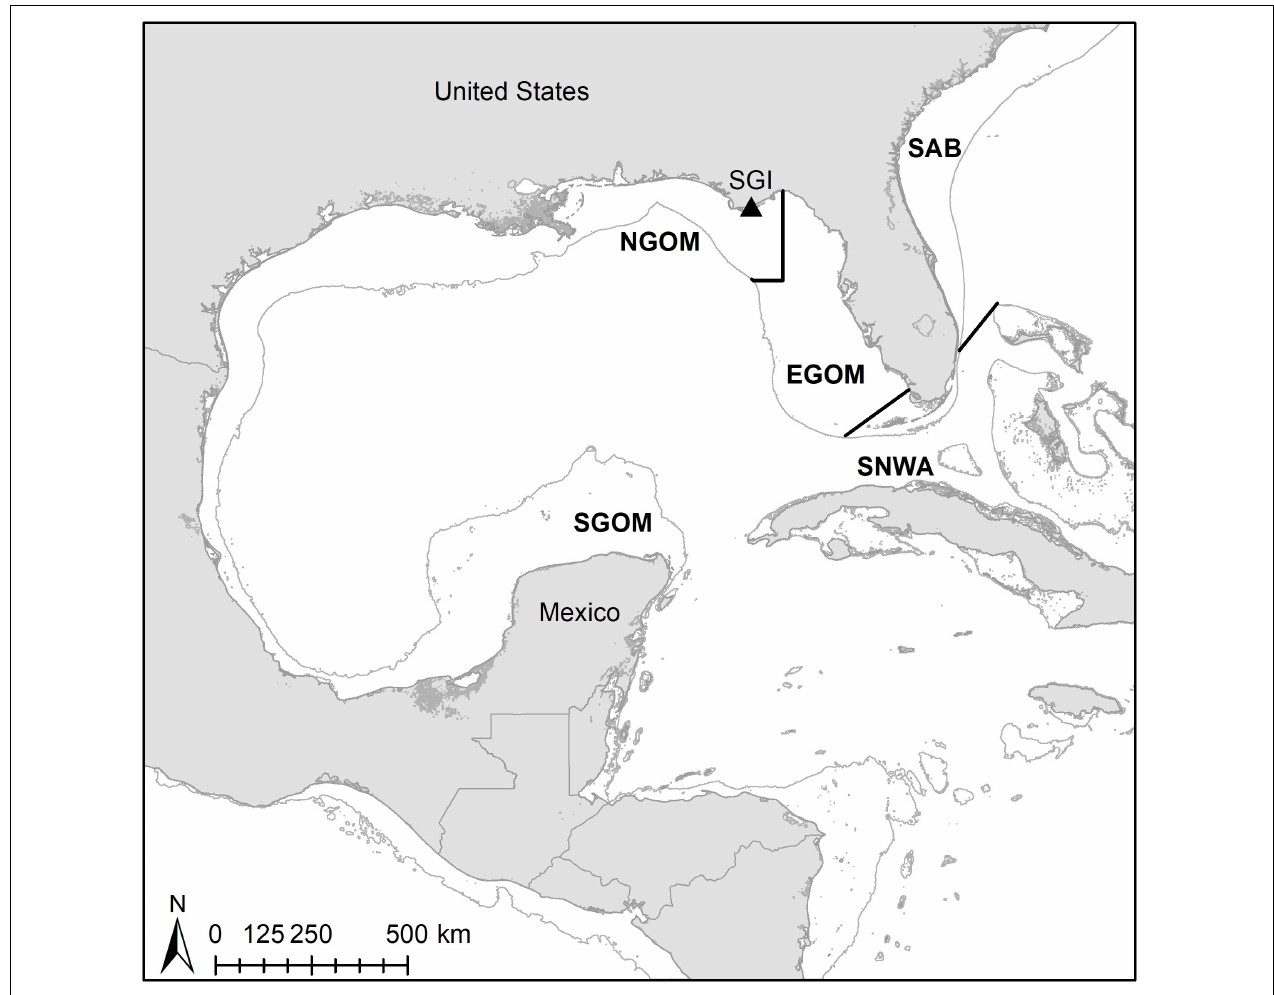
FIGURE 1 | Map of study site (St. George Island; SGI) and broad foraging regions for assignments. NGOM, Northern Gulf of Mexico; EGOM, Eastern Gulf of Mexico; SGOM, Southern Gulf of Mexico; SNWA, Subtropical Northwest Atlantic; SAB, South Atlantic Bight. Thin gray lines indicate 200-m depth